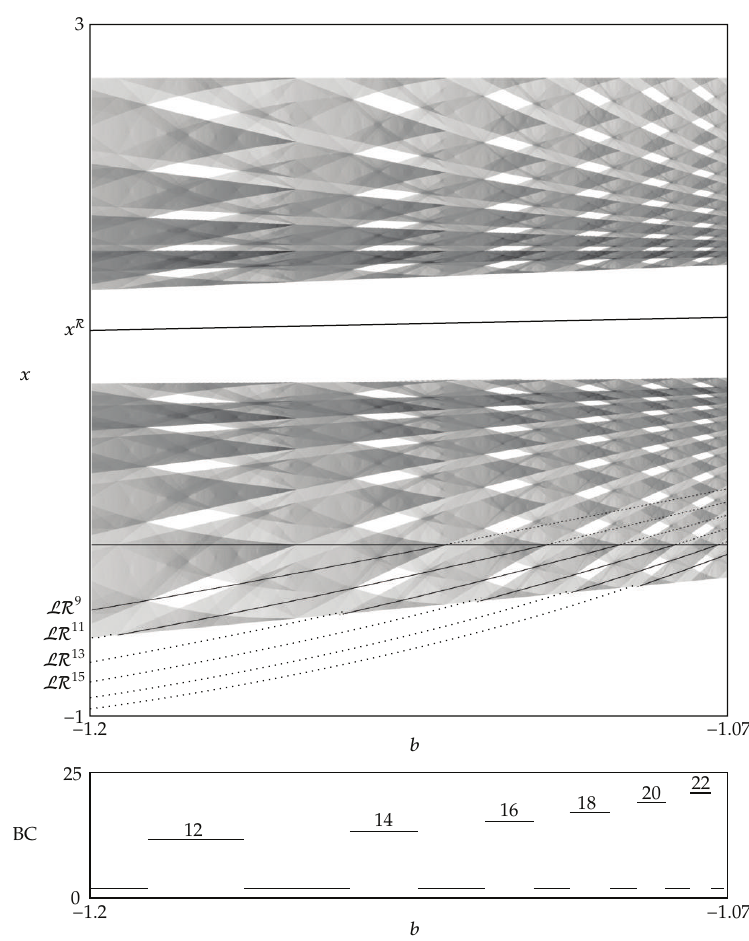
Figure 14: Bifurcation and bandcount diagrams for a (cid:6) 0 . 42, b (cid:6) − 1 . 2 ··· − 1 . 07, μ (cid:6) 1 . 7. Each curve shows a single point of unstable periodic orbits of the form O LR 2 n (cid:5) 1 , each colliding with the attractor in two band- merging crises. Only one point per orbit is shown, for the sake of clarity, but the other points of the orbits also fit the gaps. Note that all orbits shown in this image, are destroyed in border collisions at x (cid:6) 0. Their virtual parts are shown dashed. The location of this scenario in the (cid:7) b,μ (cid:8) -plane is marked with B in Figure 4 (cid:7) a (cid:8) .